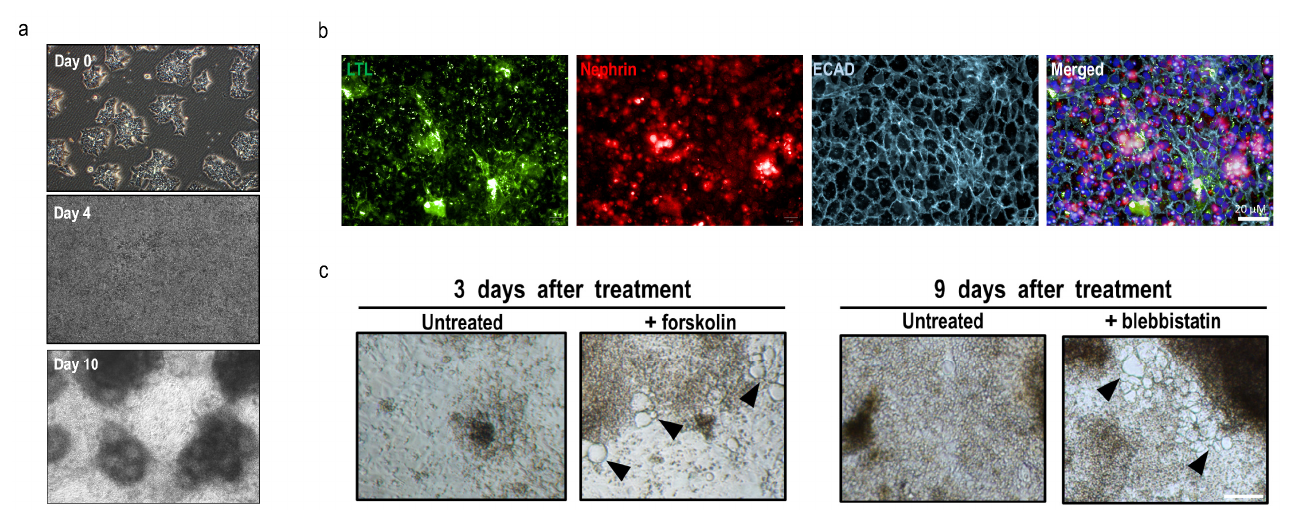
Figure 4. Directed differentiation of kidney organoids and cyst induction from MUi027-A hiPSCs. ( a ) Differentiation of MUi027-A into tubular organoids via CHIR treatment. Tubule-like structures were observed after day 8–10 post differentiation ( b ) Immunocytochemistry of organoid tubules stained with kidney markers (lotus tetragonolobus lectin; LTL, nephrin, and E-cadherin; ECAD). ( c ) Phase-contrast micrographs showing the effect of treatment with 30 µM forskolin for 3 days ( left ) or 12.5 µM blebbistatin for 9 days ( right ).